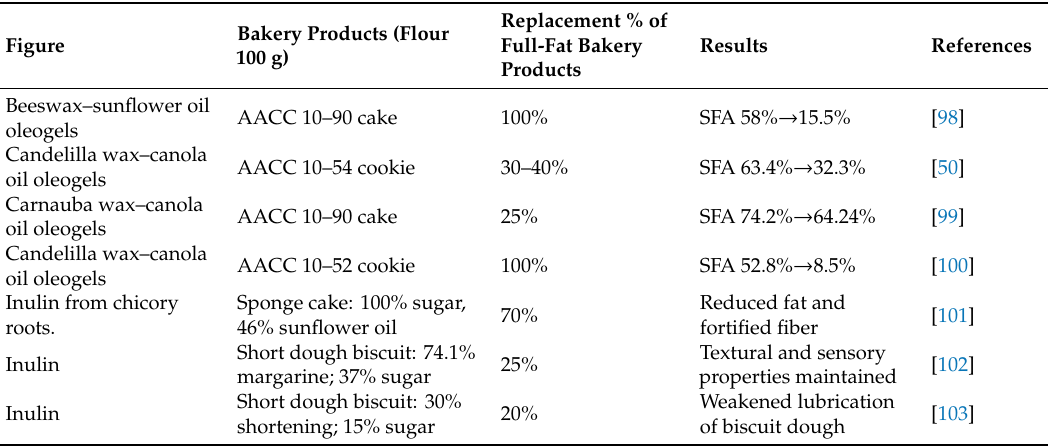
Table 5. Successful fat replacer in bakery